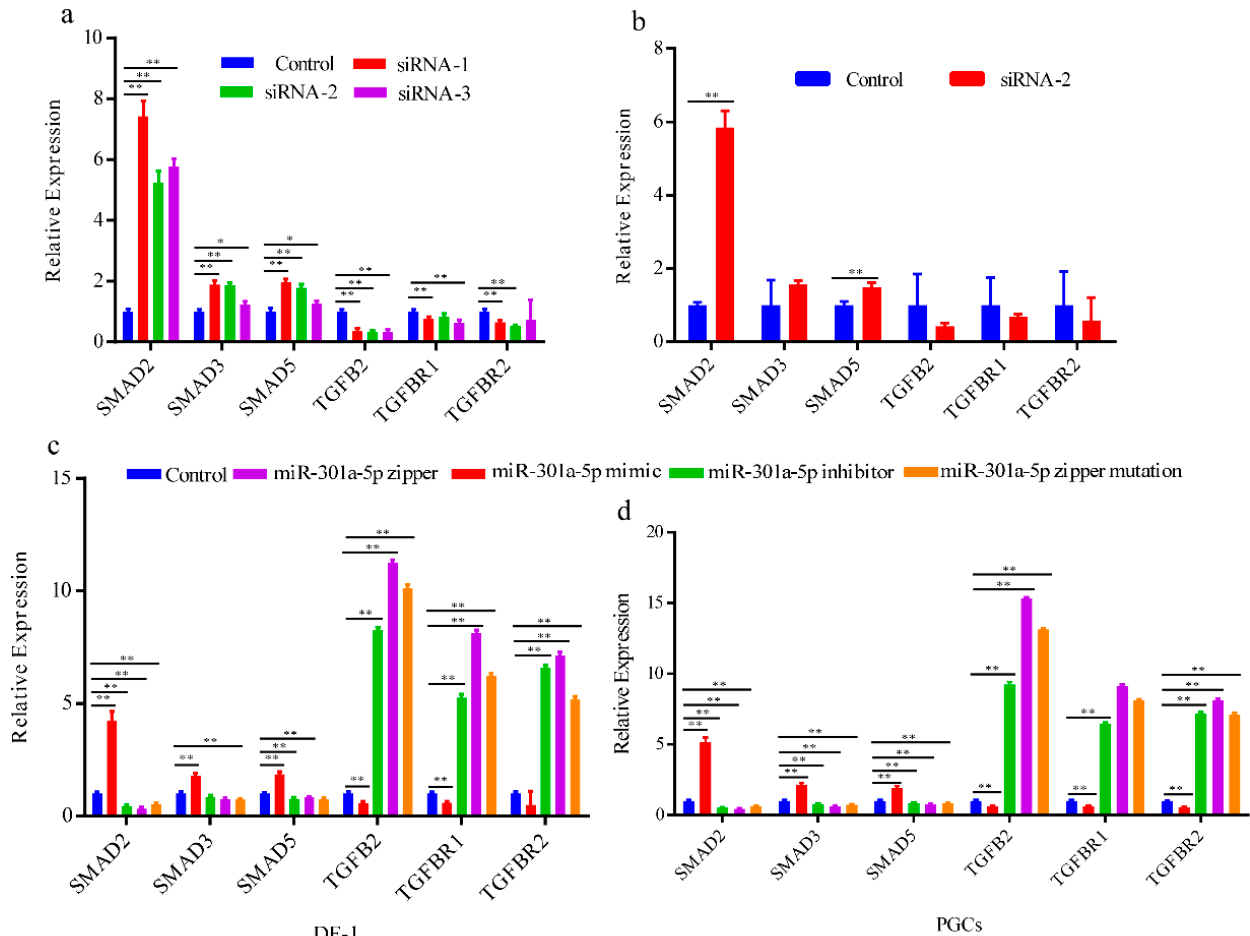
Figure 4. The function of miR-301a-5p in the TGFB pathway. ( a ) The expression changes of the download follow genes in the TGFB pathway in DF-1 after transfection with three siRNAs; ( b ) expression changes of the download follow genes in the TGFB pathway in PGCs after transfection with siRNA-2; ( c , d ) expression changes of the download follow genes in the TGFB pathway in DF-1 and PGCs after transfection with the miR-301a-5p mimic, miR-301a-5p inhibitor, miR-301a-5p zipper, and miR-301a-5p zipper mutation. Data shown as mean ± SEM, * p < 0.05, ** p < 0.01